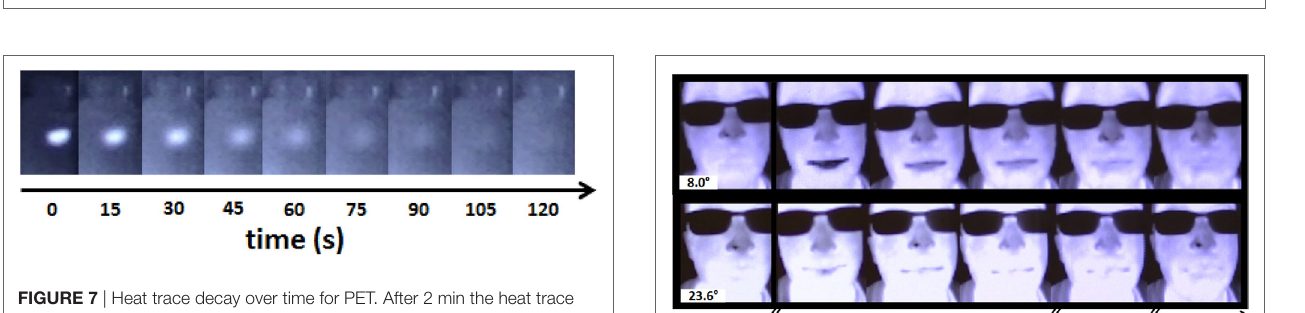
FigUre 6 | Heat trace decay over time for some typical materials for medicine intake: for (a) PET, (B) HD-PE, (c) paper, (D) glass, and (e) ceramic; RGB data (left), thermal data soon after touching (center), and thermal data after 30 s (right).